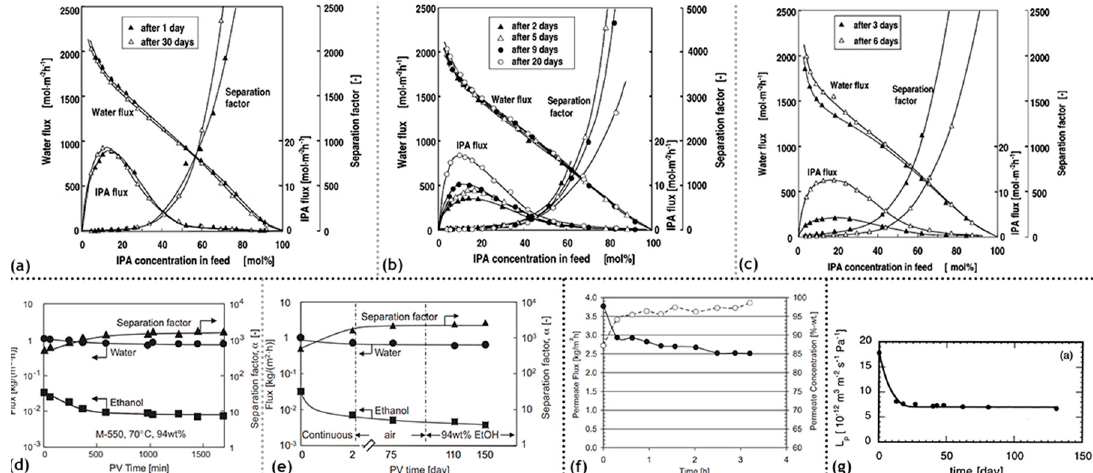
Figure 12. ( a ) Observed pervaporation characteristics for isopropanol/water mixtures at normal boiling points with a SiO 2 –ZrO 2 (ZrO 2 : 40%) membrane fired at 400°C (with washing in boiling water). ( b ) Observed pervaporation characteristics for IPA/water mixtures at normal boiling points with a SiO 2 –ZrO 2 (ZrO 2 : 30%) membrane fired at 400°C (with washing in boiling water). ( c ) Observed pervaporation characteristics for isopropanol/water mixtures at normal boiling points with a SiO 2 –ZrO 2 (ZrO 2 : 20%) membrane fired at 400°C (with washing in boiling water). Adapted from [2],